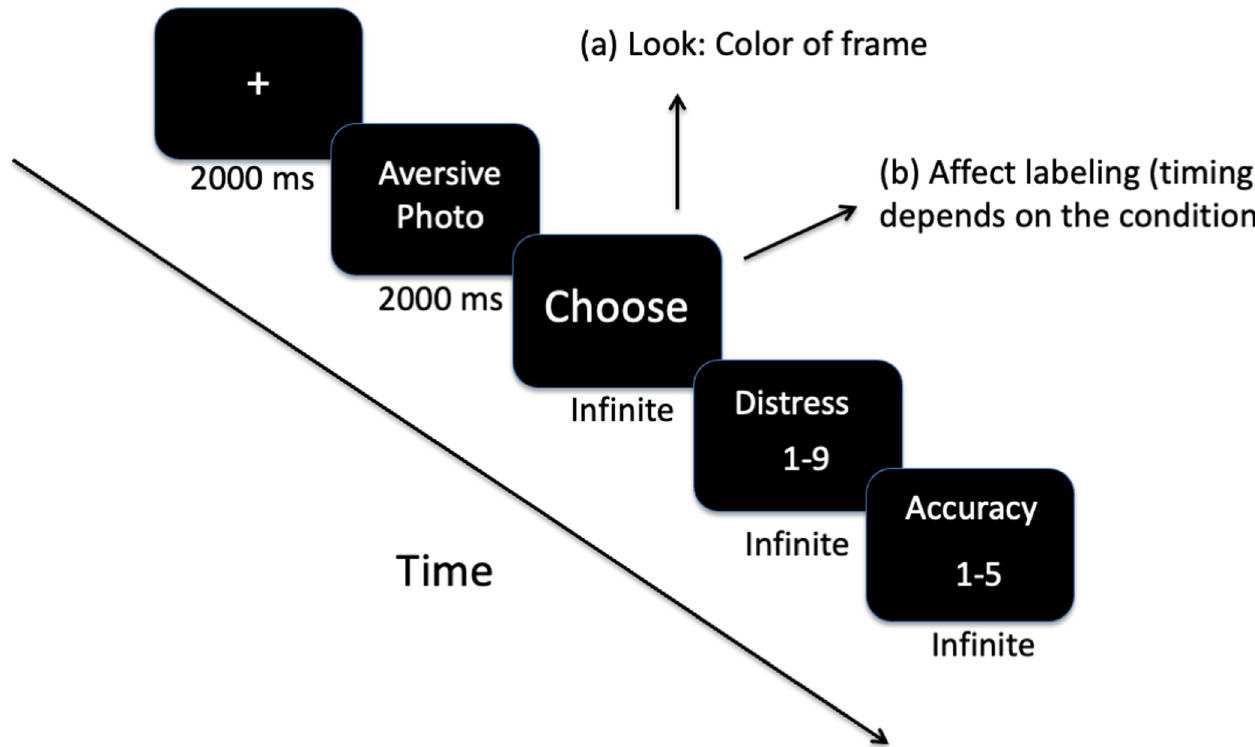
Fig 1. Illustration of the affect labeling